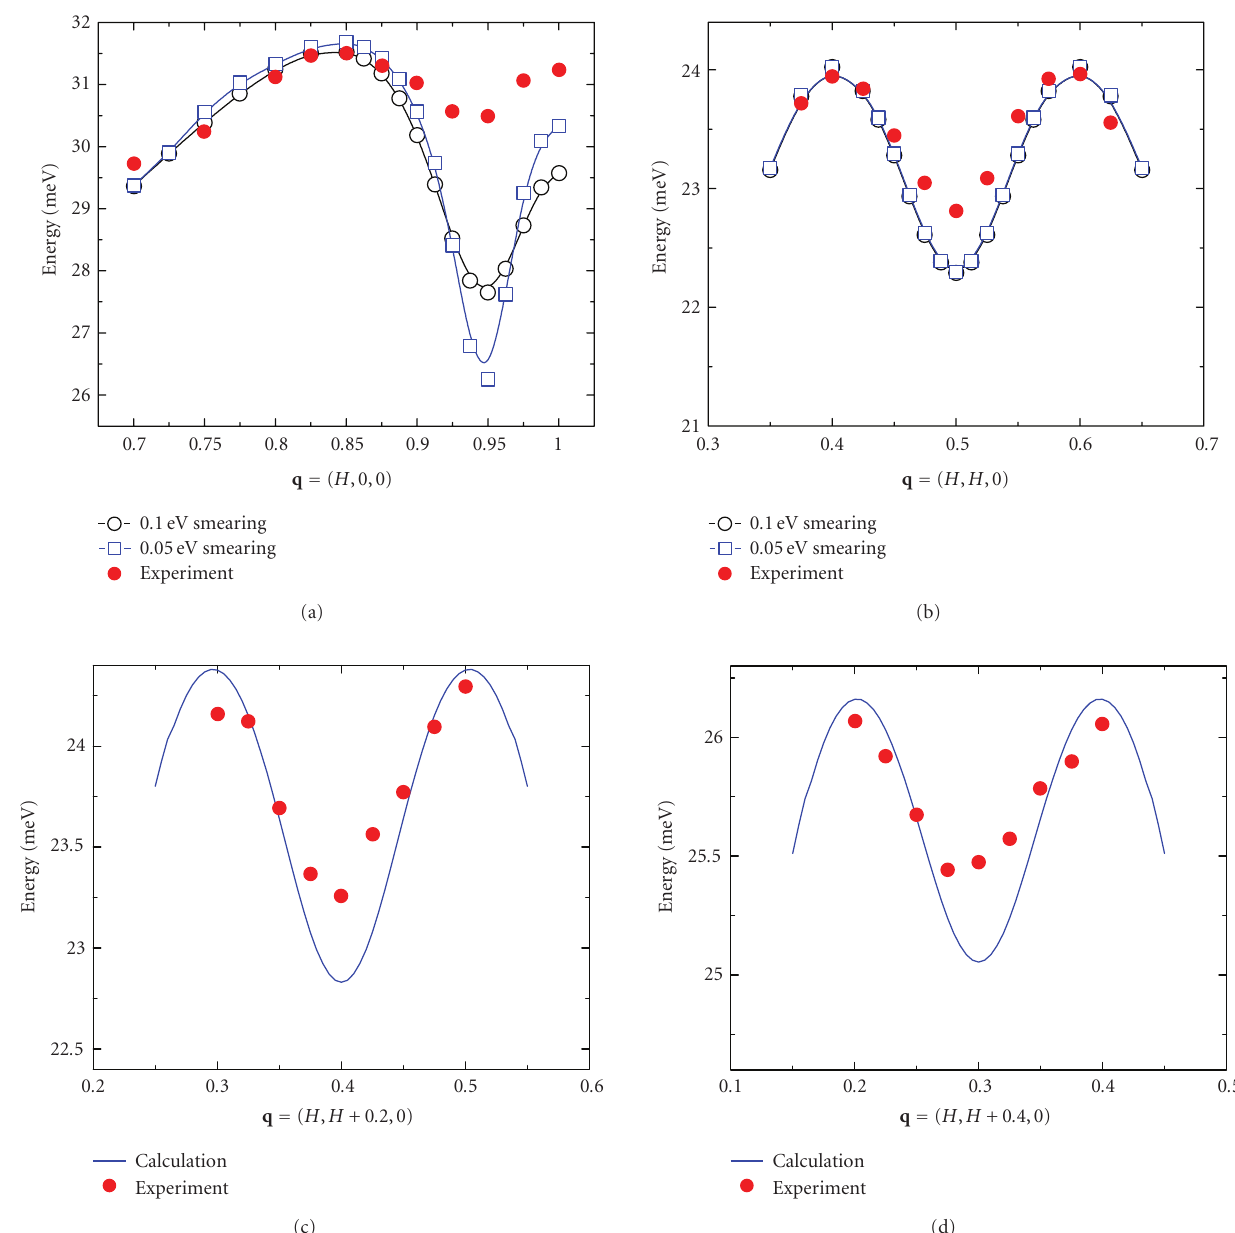
Figure 6: A comparison between measured (red) and calculated (blue, black) phonon dispersions and the LDA calculation in Cr. Only the data for the lowest energy transverse phonons near the zone boundary line connecting q = (1,0,0) and q = (0 . 5,0 . 5,0) are shown. The smearing has a strong e ff ect in (a) but not in (b) (from